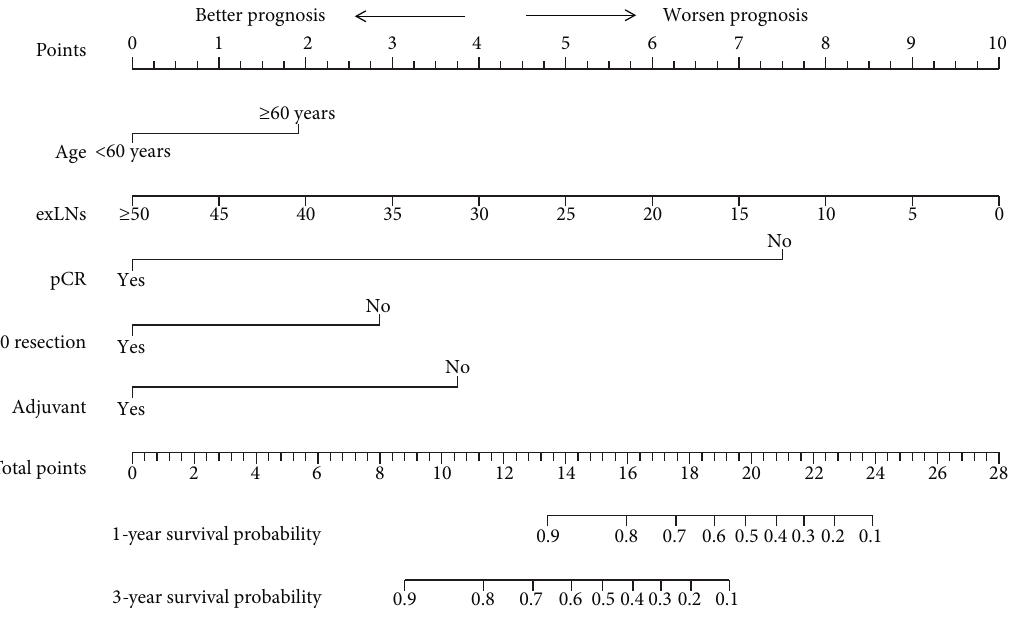
Figure 2: Parameters in Tables 1 – 3 with a p value < 0.05 were included in the Cox regression model to build a nomogram predicting 1- and 3- year survival after neoadjuvant chemotherapy and surgery. exLNs: examined lymph nodes; pCR: pathological complete response; Adjuvant: adjuvant chemotherapy.